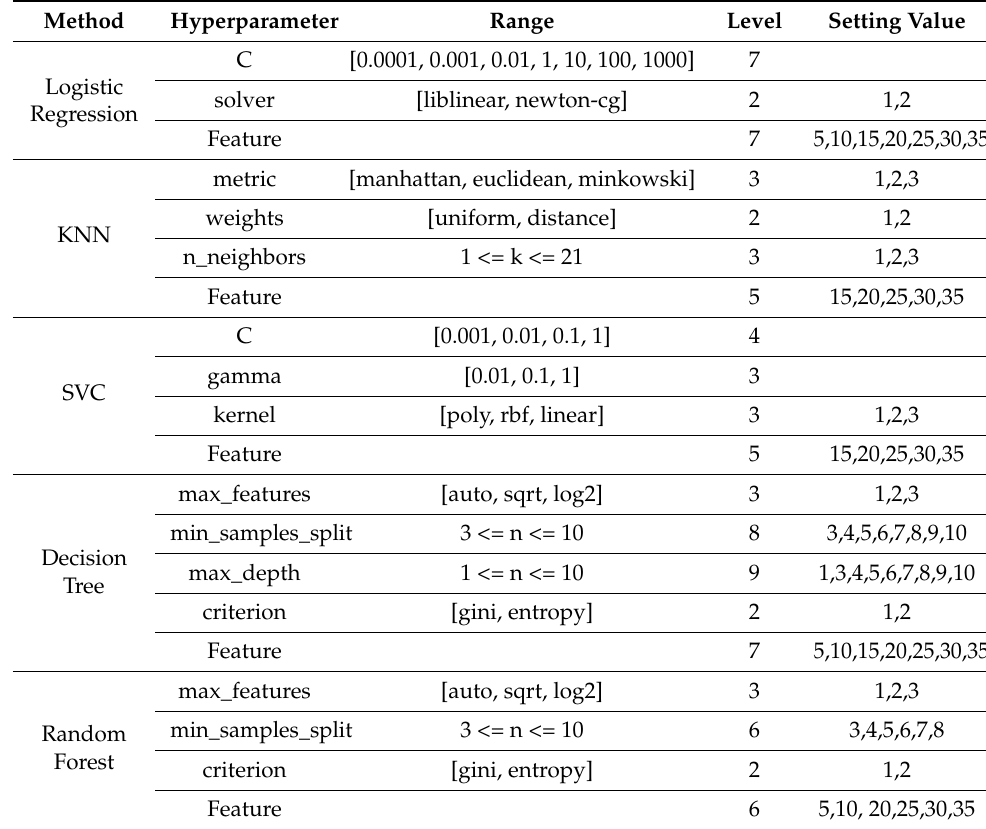
Table 6. Model parameters and setting ranges for each